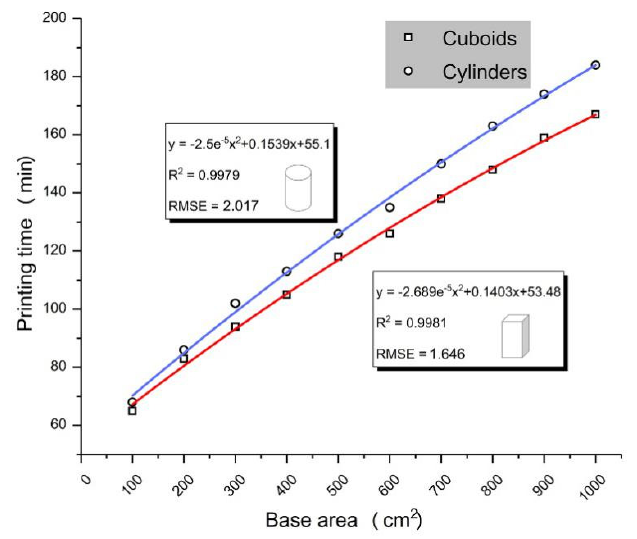
Figure 1. Printing time - basal area fitting curves.